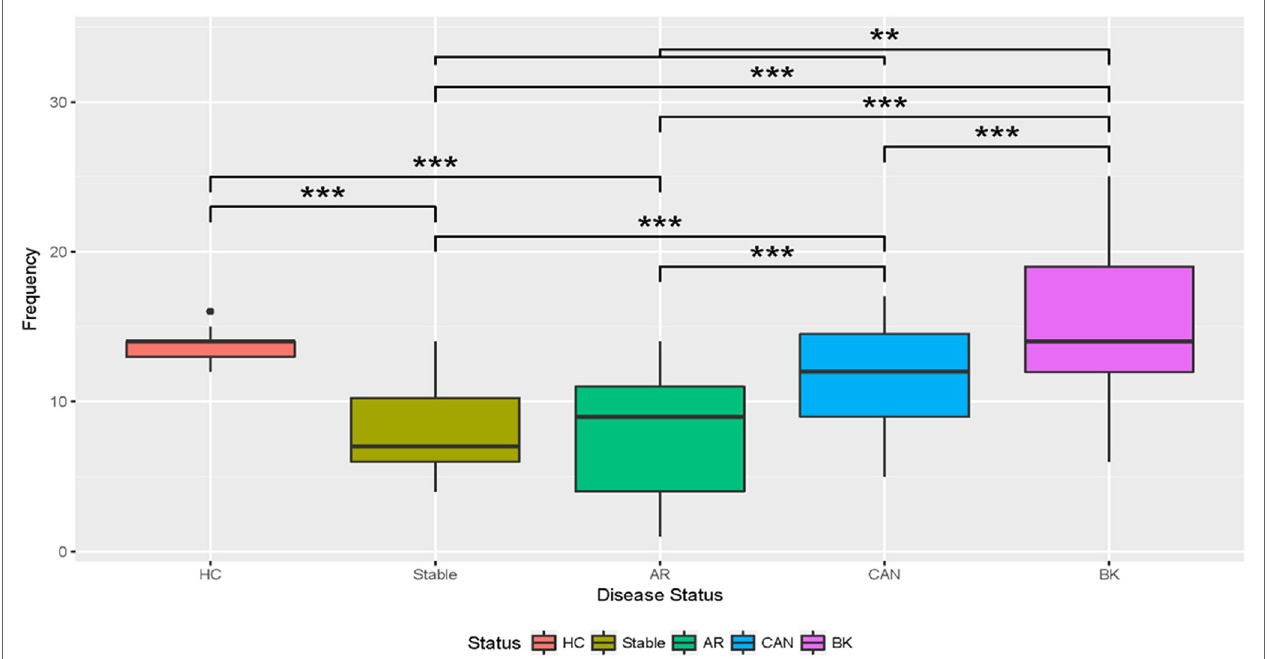
FigUre 3 | Boxplots of the number of unique viruses discovered by disease status. The boxplots show that the relative abundance of unique viruses discovered in stable and acute rejection (AR) patients is lower than the number discovered in healthy control (HC). The number of viruses discovered increased in chronic allograft nephropathy (CAN) above stable and AR. The number of viruses increased in BK over all immunosuppressed categories. T -Tests with Bonferroni corrections were used for multiple testing. *Significant at p < 0.05; **significant at p < 0.005; ***significant at p <